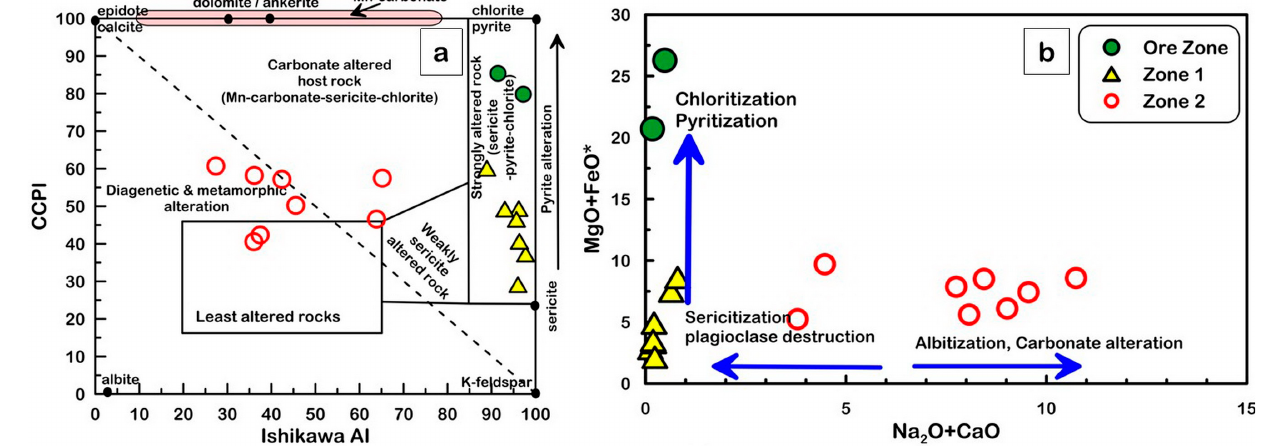
Figure 13. ( a ) AI [60] vs. CCPI [59] of the studied alteration samples of Abu Zawal area. ( b ) Na 2 O + CaO vs. MgO + FeO*(FeO total) after Paulick et al. [61]. Table 4. Major oxides, trace, and REE of the ore zone and different alteration zones of Abu the Zawal (Fatira) area.